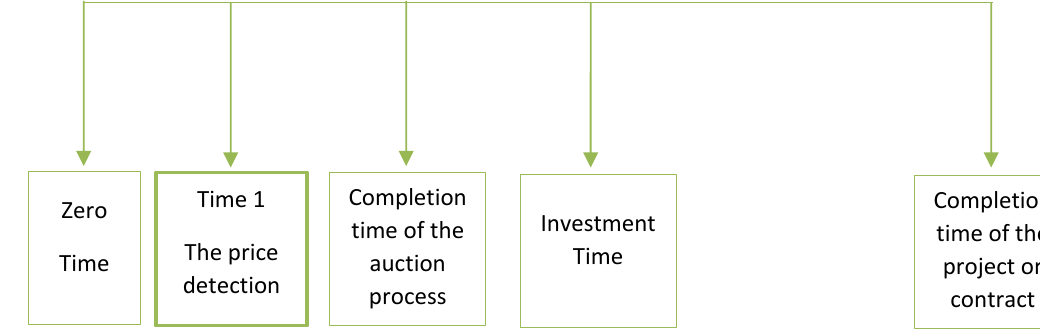
Fig. 3. Scheduling based on the proposed mechanism Fig. 3: Scheduling based on the proposed